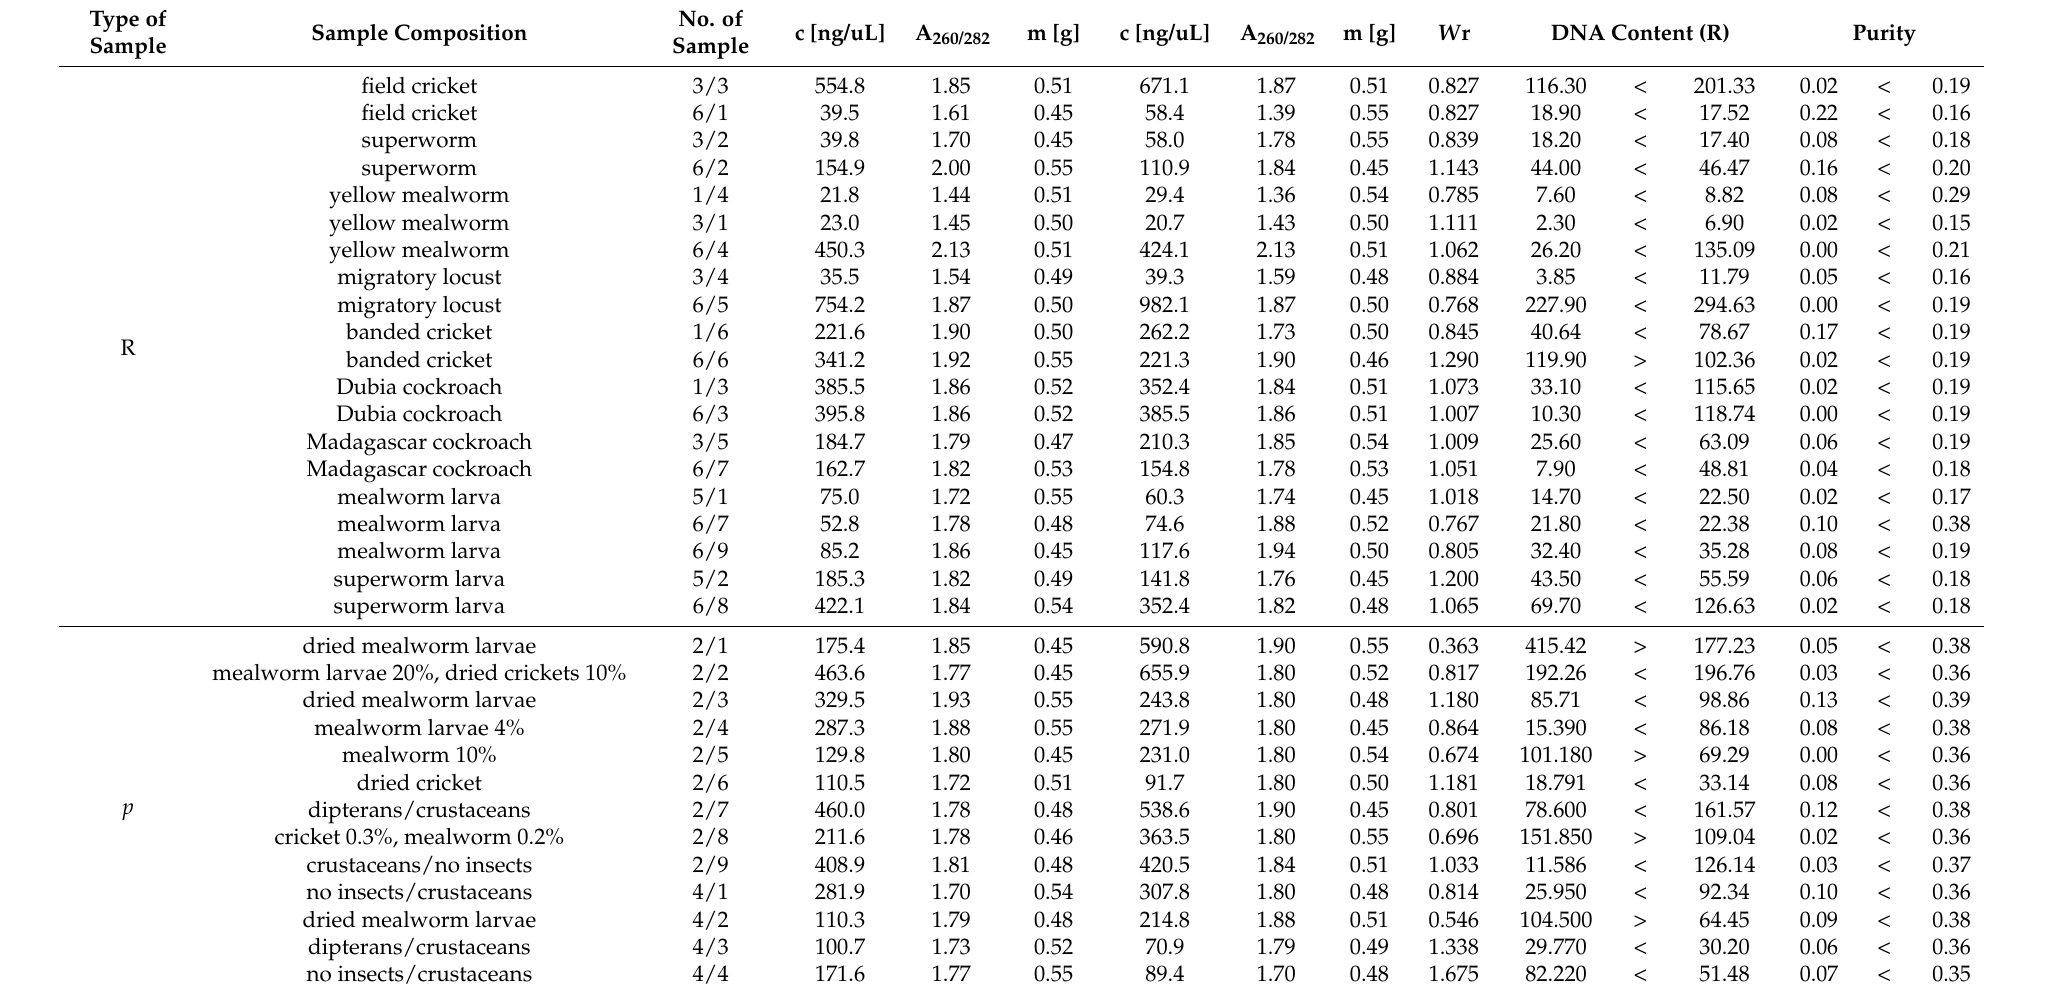
Table 3. Parameters of DNA isolates of insects (R) and processed commercial food products ( p